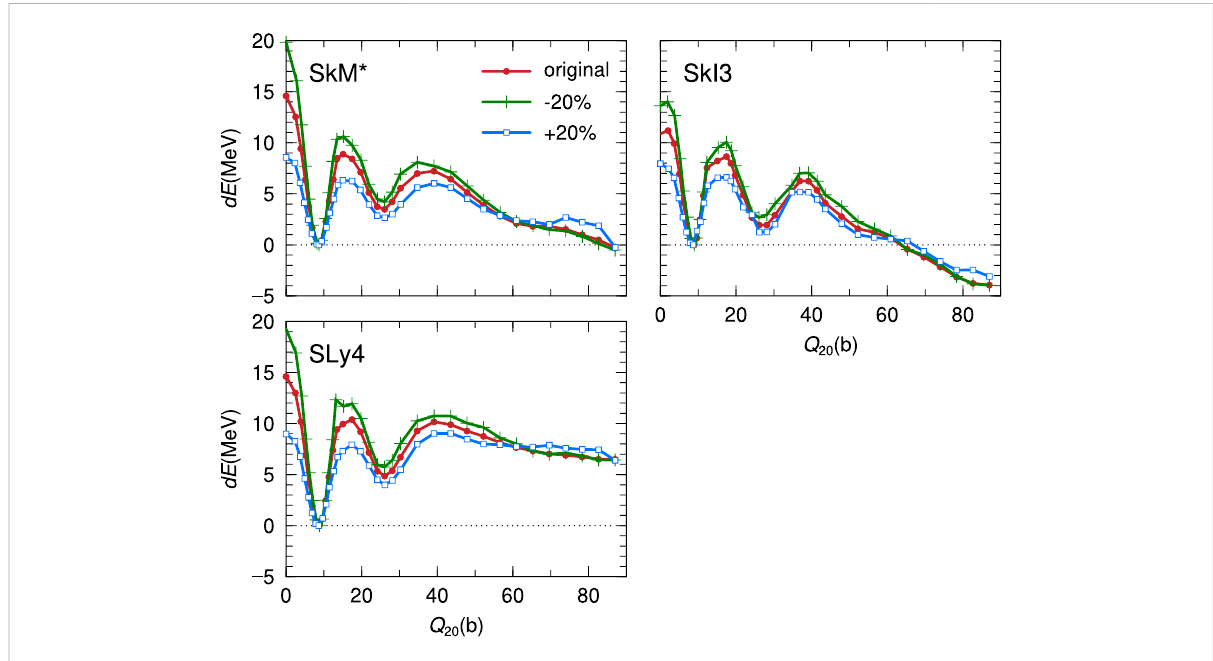
FIGURE 5 The dE on the fi ssion paths of 236 U for the three EDFs (SkM*, SLy4, SkI3) with the original strength of G (circle), − 20% G (cross), and + 20% G (square).